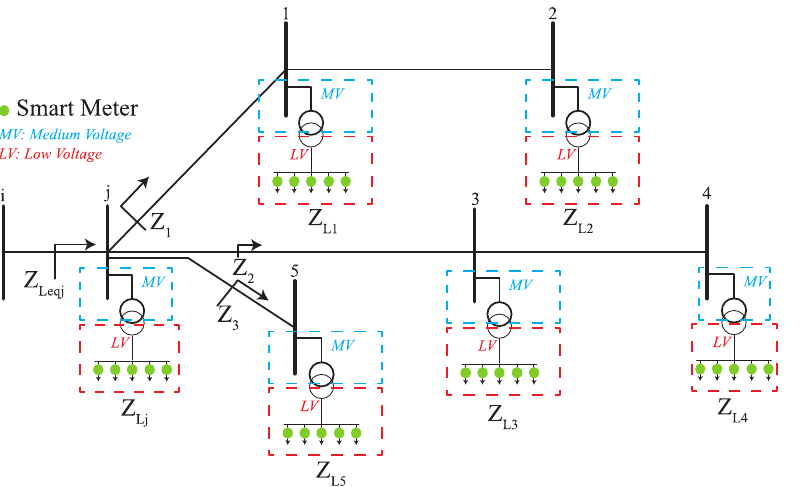
Figure 1. Single line diagram of a sample network with SMs in the low voltage side of the network.